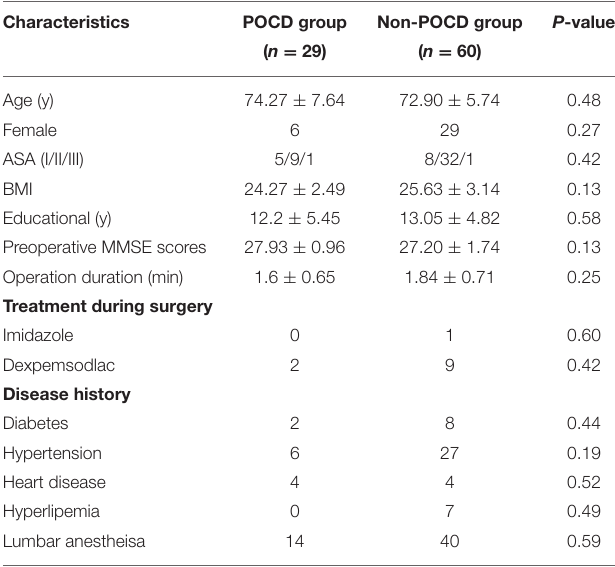
TABLE 1 | Baseline of the study